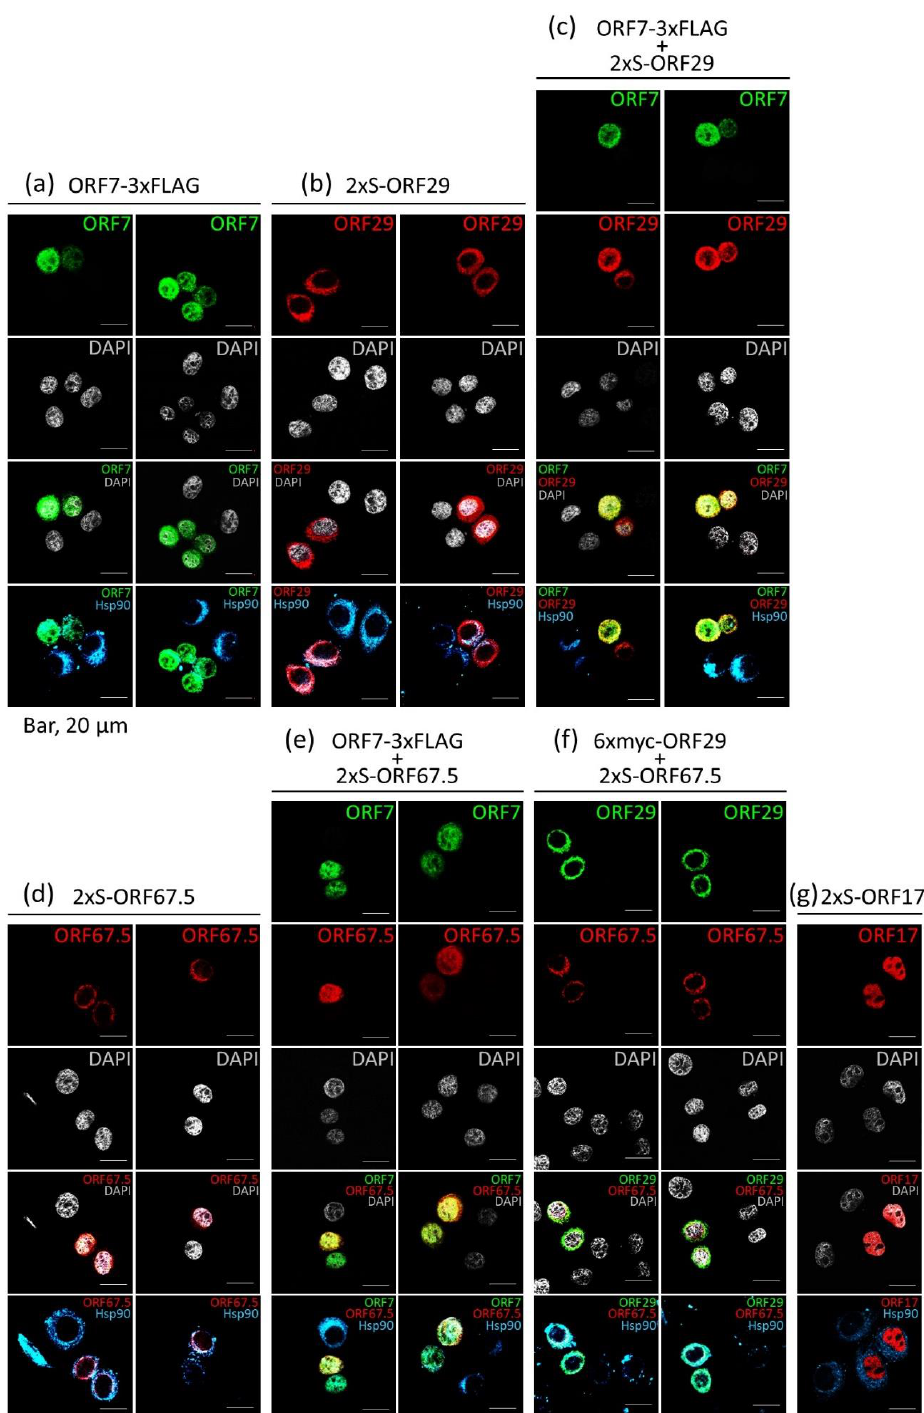
Figure 4. ORF7 induces nuclear relocalization of ORF29 and ORF67.5. HeLa cells were transfected with ORF7-3xFLAG ( a ), 2xS-ORF29 ( b ), 2xS-ORF67.5 ( d ), and 2xS-ORF17 ( g ) plasmids and stained with anti-HSP90beta (cyan) and either anti-FLAG (green) or anti-S tag (red) antibodies. ( a – g ) DNA was visualized with DAPI staining (white). Immunofluorescent images were obtained with an inverted confocal microscope. For colocalization with ORF7, ORF7-3xFLAG plasmids were cotransfected with 2xS-ORF29 ( c ) or 2xS-ORF67.5 ( e ) plasmids into HeLa cells. The cells were stained with anti-FLAG (green), anti-S tag (red), and anti-HSP90beta (cyan) antibodies. For colocalization of ORF29 and OR67.5 ( f ), 6xmyc-ORF29 was cotransfected with 2xS-ORF67.5, and HeLa cells were stained with anti-myc (green), anti-S tag (red), and anti-HSP90beta (cyan)